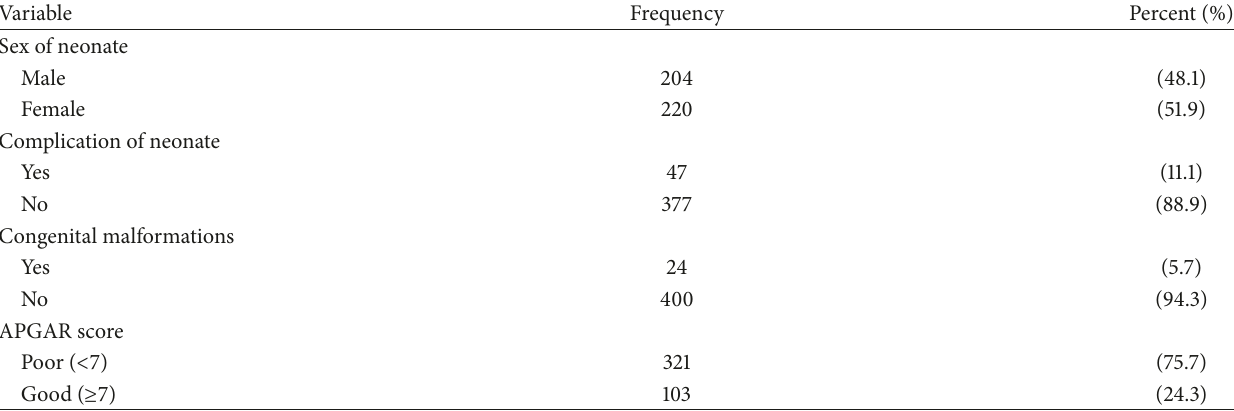
Table 3: Neonatal history of the